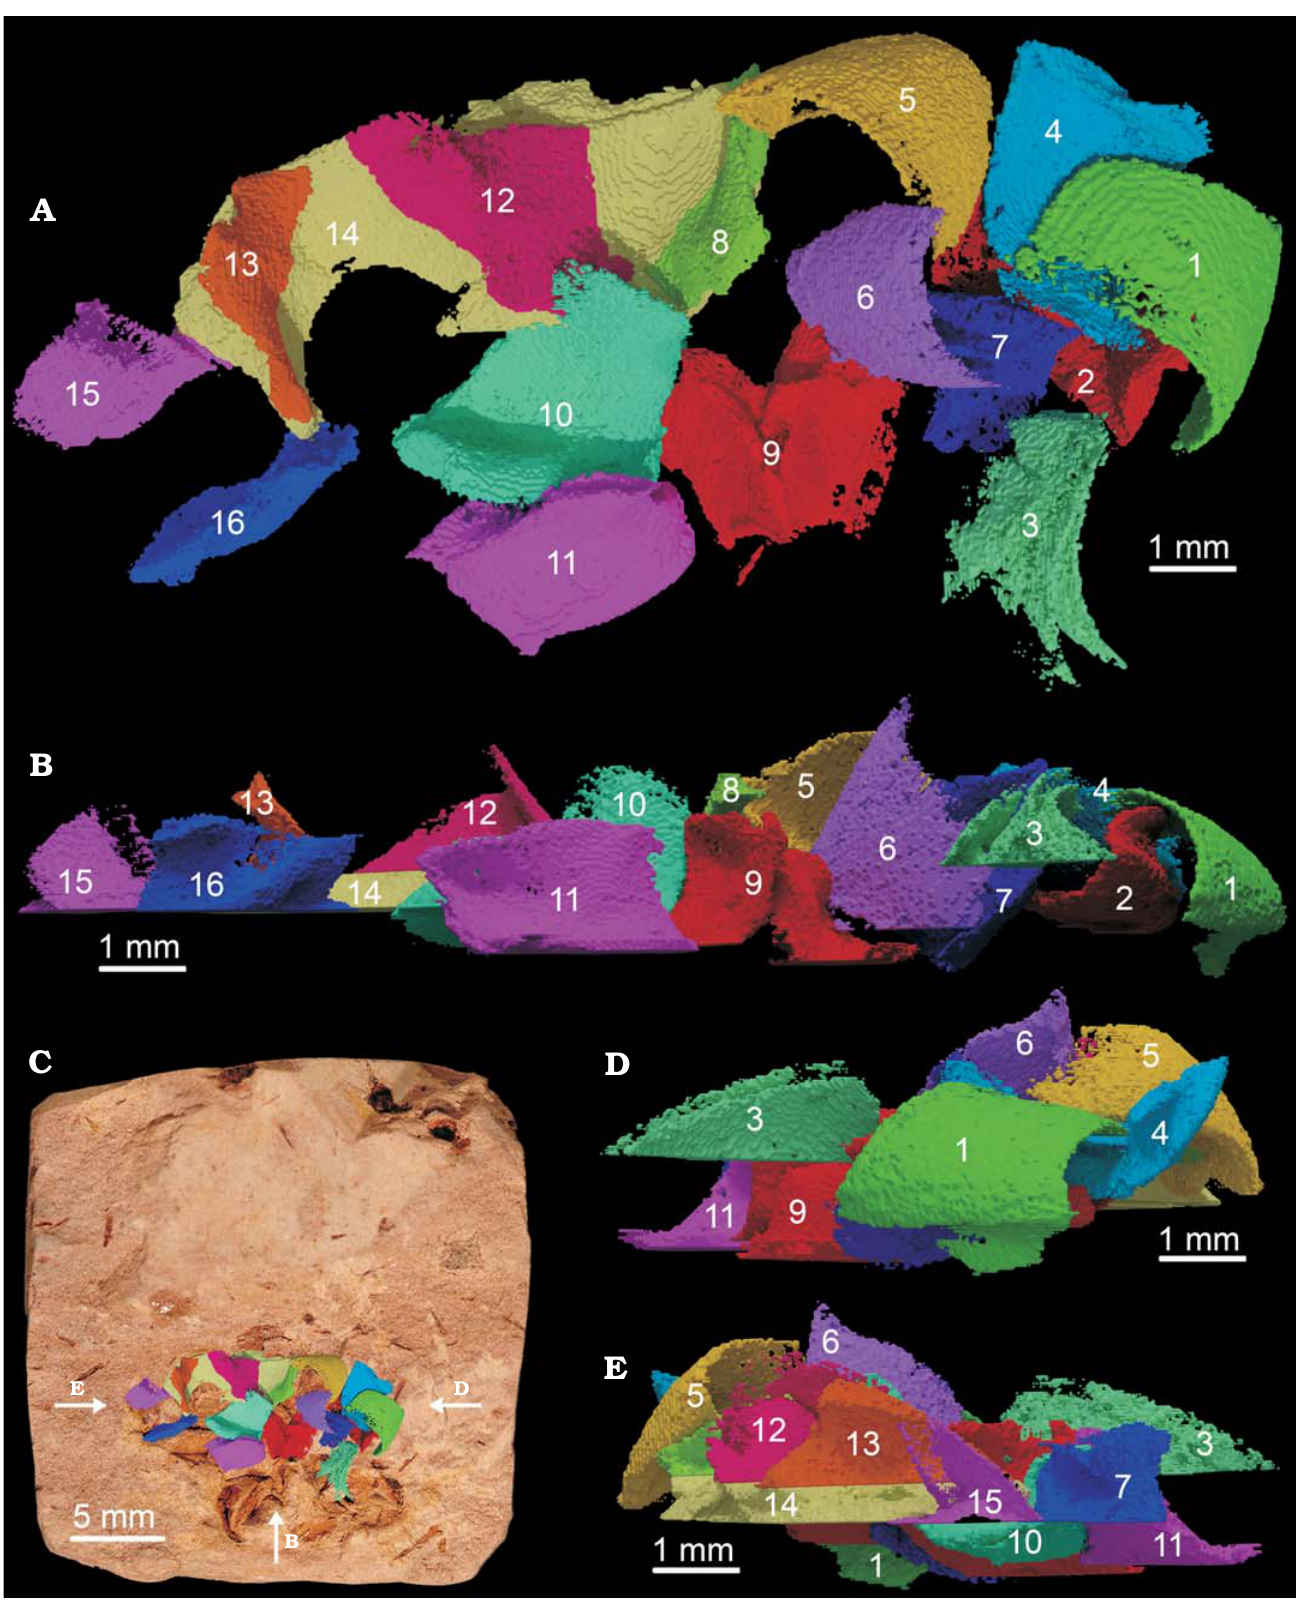
Fig. 3. Overview over the assemblage of the sixteen 3D-objects which were created from different viewpoints. Orthographic top ( A ) and front ( B ) views. Orthographic top view ( C ), projected on the sample to show the position of the 3D-model in the correct position on the x-y-plane and corresponding viewing directions. Orthographic left side ( D ) and right side ( E )